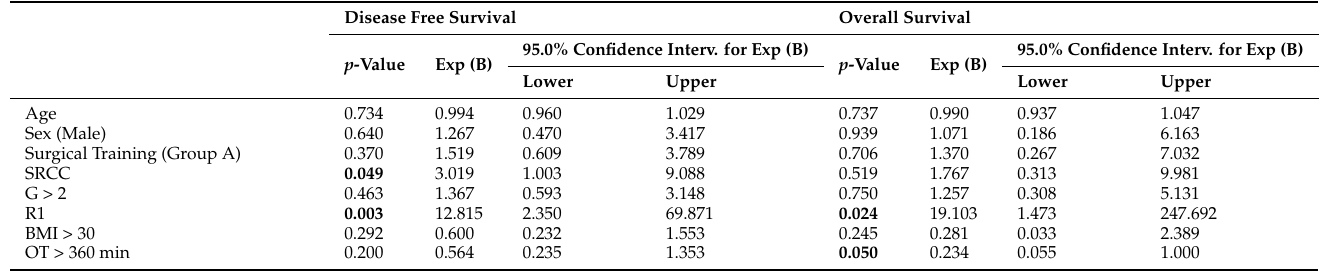
Table 5. Cox proportional hazard model for overall survival and disease-free survival. Disease Free